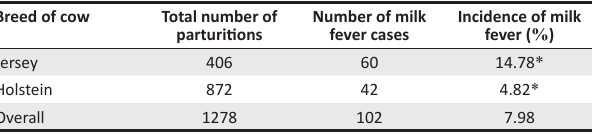
TABLE 1: Incidence of milk fever according to breed of